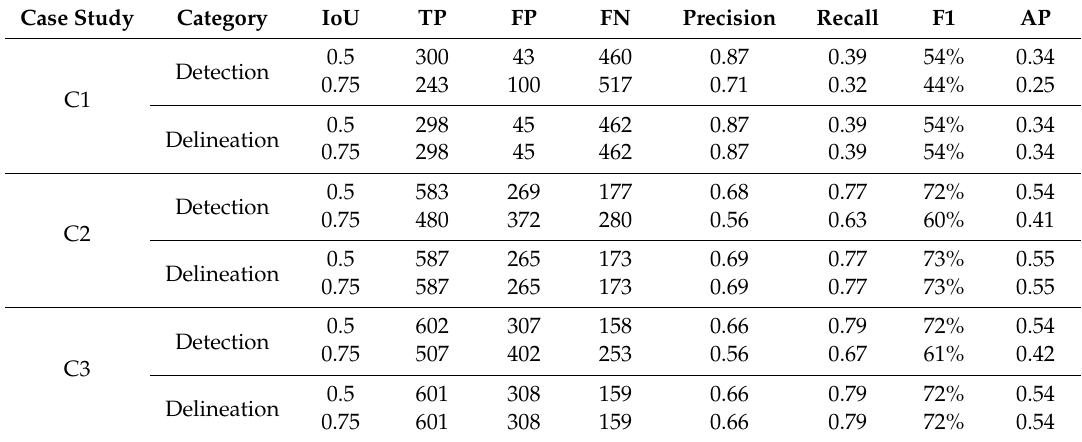
Table 5. Comparison of results of di ff erent processing combinations of quantitative assessment based on case testing